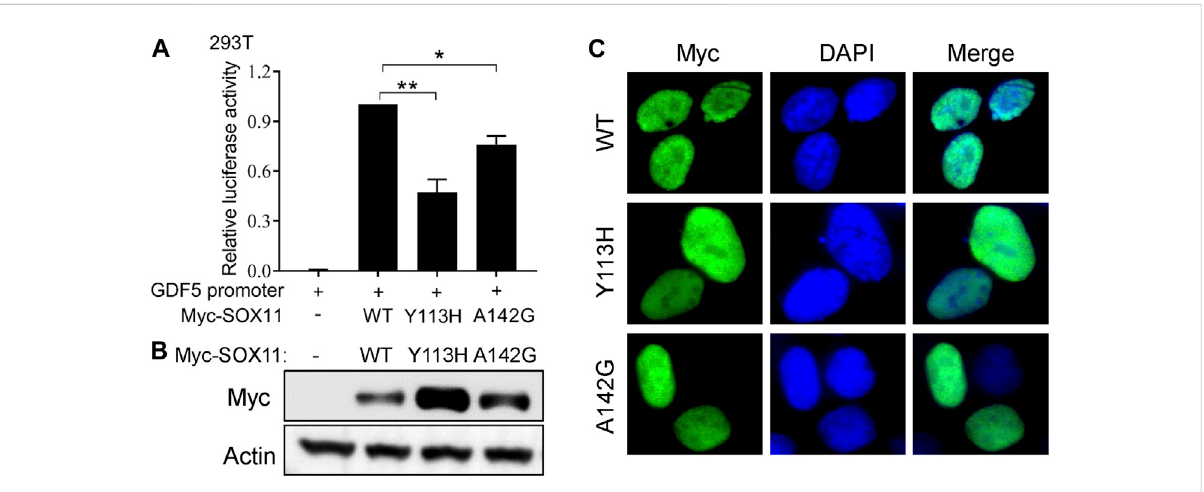
FIGURE 3 Functional studyoftheSOX11missensevariants. (A) Transcriptionalactivityofthe GDF5 promoterwasdeterminedbyluciferasereporterassays in HEK293T cells after co-transfection of the WT or the mutant Myc- SOX11 and the GDF5 promoter reporter construct. Data are presented as mean values ±s.e.m. from three independent experiments. * p < 0.05, ** p < 0.01, two-tailed Student ’ s t -test. (B) The expression level of the WT and the mutant (Y113H and A142G) Myc-SOX11 were evaluated by immunoblotting in HEK293T cells. (C) Immuno fl uorescence analysis to show the subcellular localization of the WT and the mutant (Y113H and A142G)